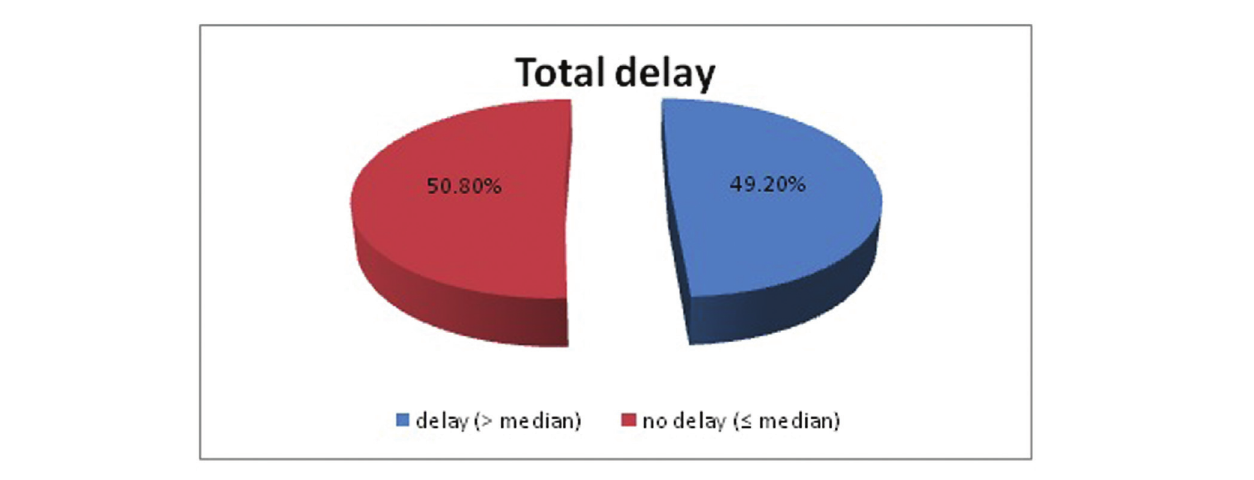
Proportion of total delay among the studied patients ( N = 183).